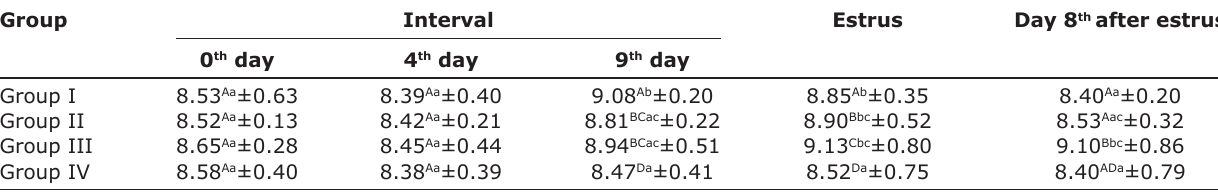
Table-3: Effect of herbal supplementation on mean serum calcium concentration (mg/dl) in various groups and intervals (ANOVA-one way). Group